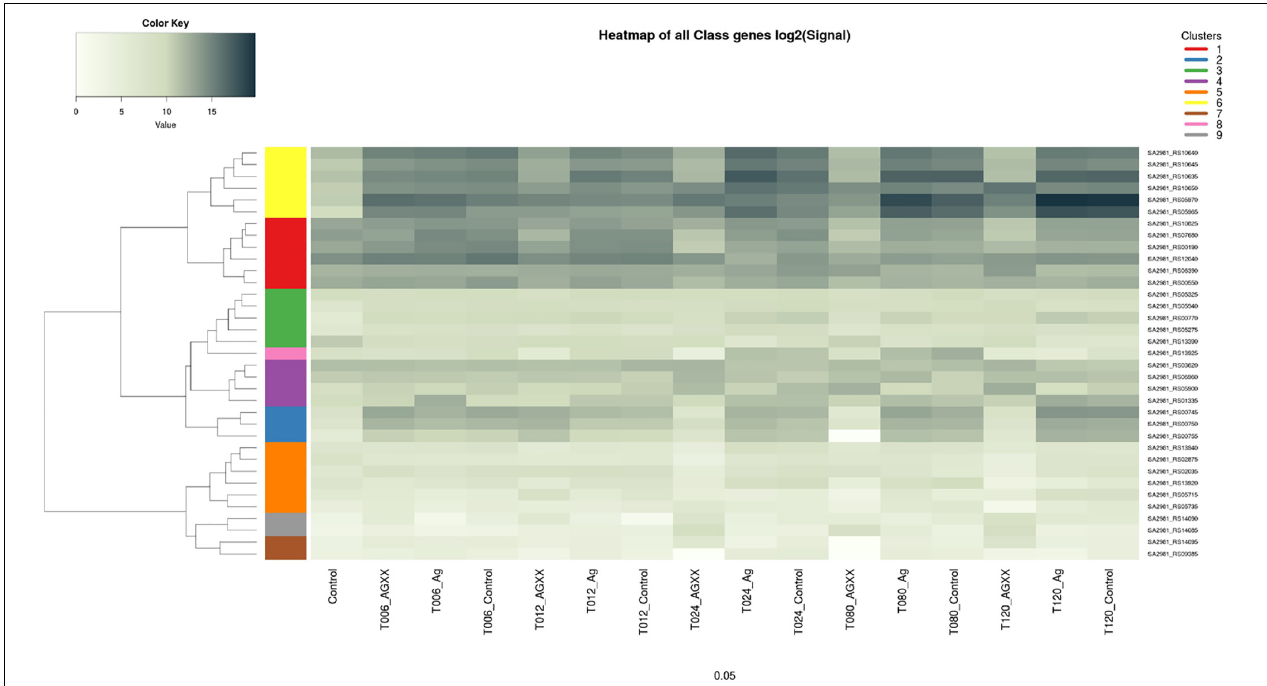
FIGURE 5 | Heatmap of differential expression of biofilm, and virulence-associated genes in S. aureus 04-02981. The genes are clustered as indicated by the dendrograms on the left side of the heatmap. Yellow represents genes agrD, ∗ agrC, agrB, agrA , and PSM- β , red represents genes sigB, ∗ srrA, mecA, sarR, codY, and sarH1 . Green color is for genes fmtA, arcD, capF , sspb, cidA , pink represents arcA while purple is for saeR, fmtC , hemolysin II, and lrgA genes. Blue represents genes mediating capsular polysaccharide synthesis, namely, ∗ capA , capB, capC . aur, ∗ sdrC , exotoxin 6, arcB, isdC, and srtB are shown in orange. Gray represents icaD , and icaA and brown color represents icaB , and ∗ lukE genes. ∗ Indicates genes selected for RT-qPCR.